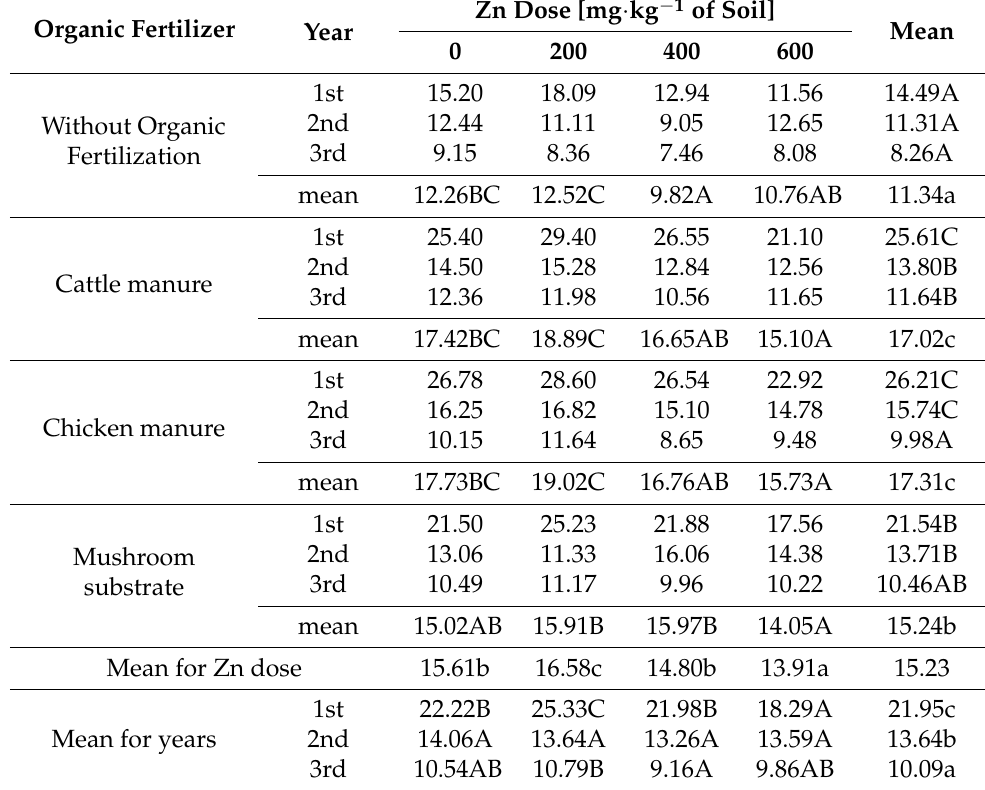
Table 2. Cocksfoot yield (g · pot − 1 ).